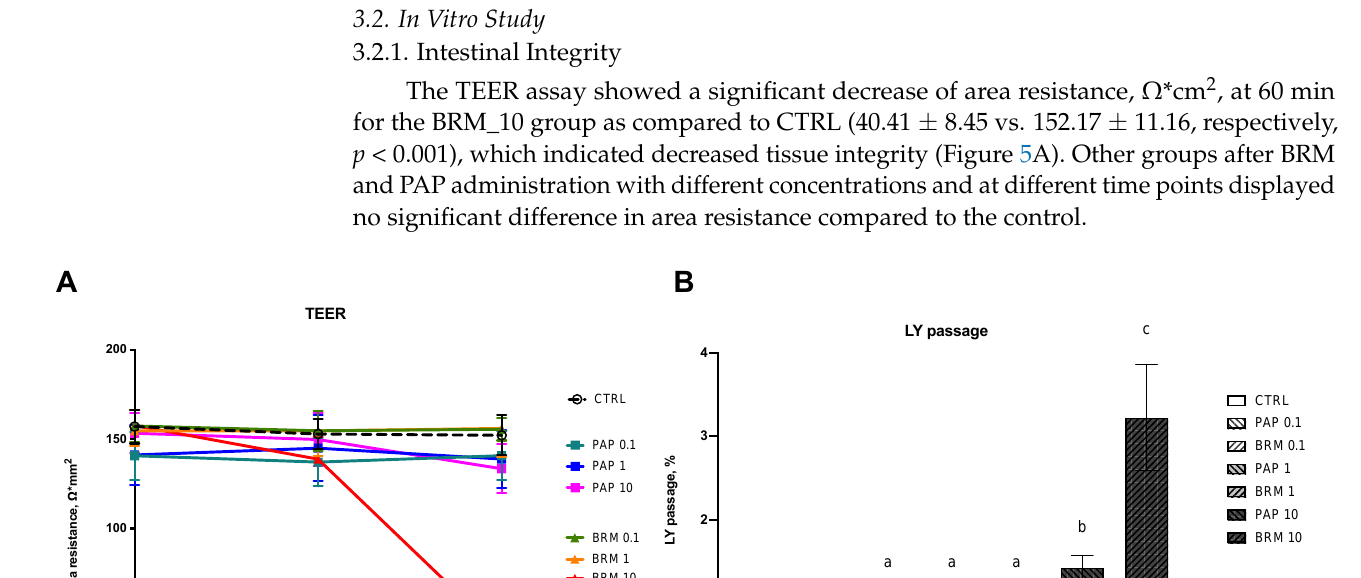
Figure 4. Effect of bromelain and papain on the activity of trypsin in the pancreas ( A ) and cecum ( B ). A t-test was used, and the Pearson correlation test was used to determine the total protease activity to total protein in the cecum ( C ). Significant differences denoted by * p < 0.05, ** p < 0.01 *** p < 0.001. Values are represented as mean ± SEM for n = 6 – 7 per group.